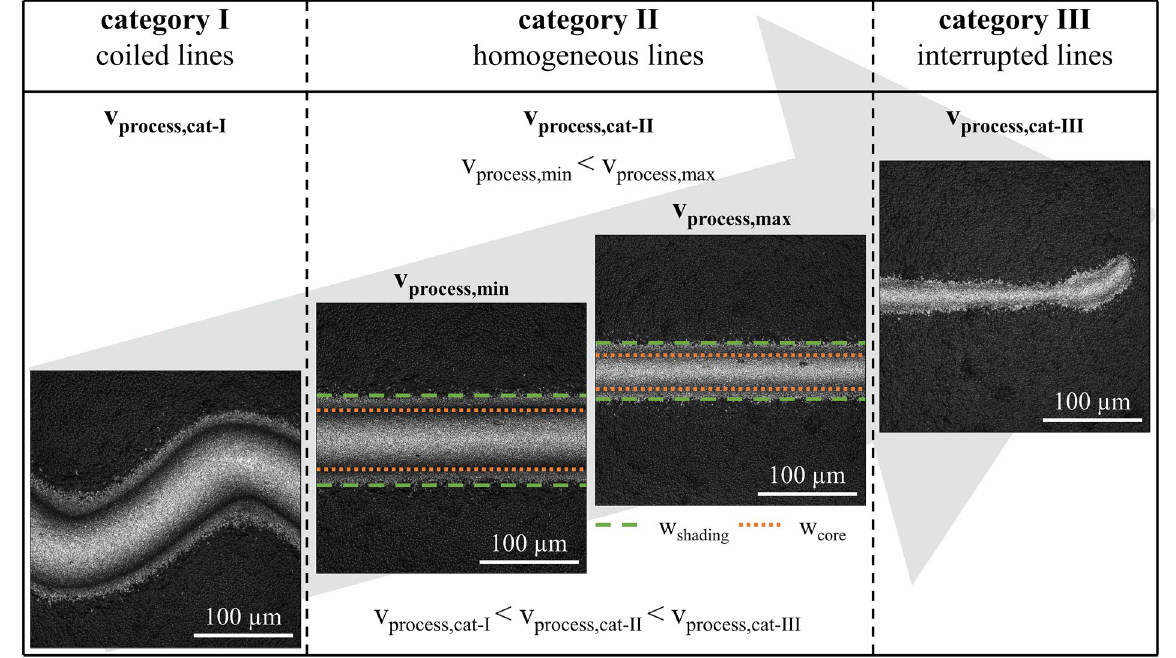
Figure 6. Classification of dispensed Ag-electrode shapes. Representative microscope images of different qualities of dispensed shapes of paste A (D = 45 µm) are depicted. Dispensing paste A with a process velocity of v process,cat-I = 90 mm s −1 results in coiled lines (category I, left). For the process velocities between v process,min = 140 mm s −1 (w shading = 85 µm) and v process,max = 410 mm s −1 (w shading = 54 µm), homogeneous, straight line shapes with different widths are observed (category II, center). At a process speed greater than v process,cat-III = 490 mm s −1 interrupted printing emerges (category III,